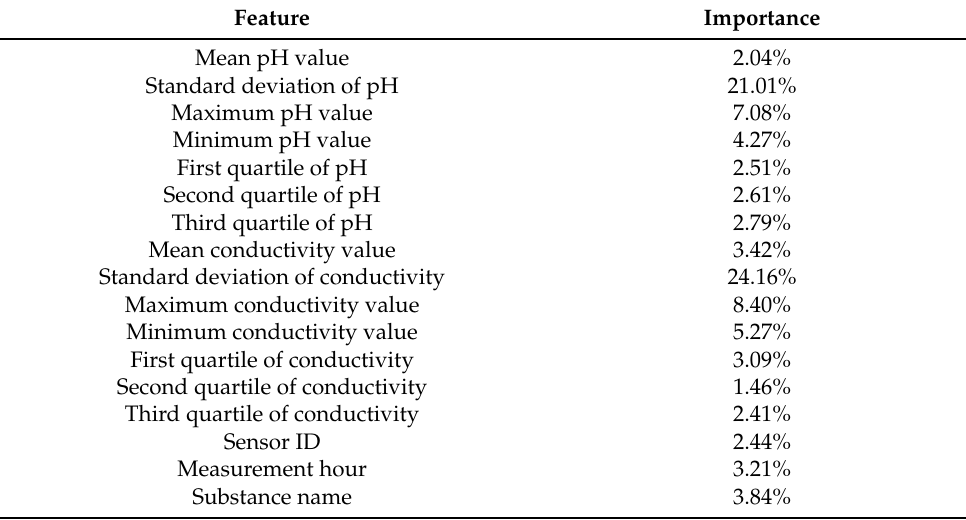
Table 4. Feature importance—pollutant source location estimation.